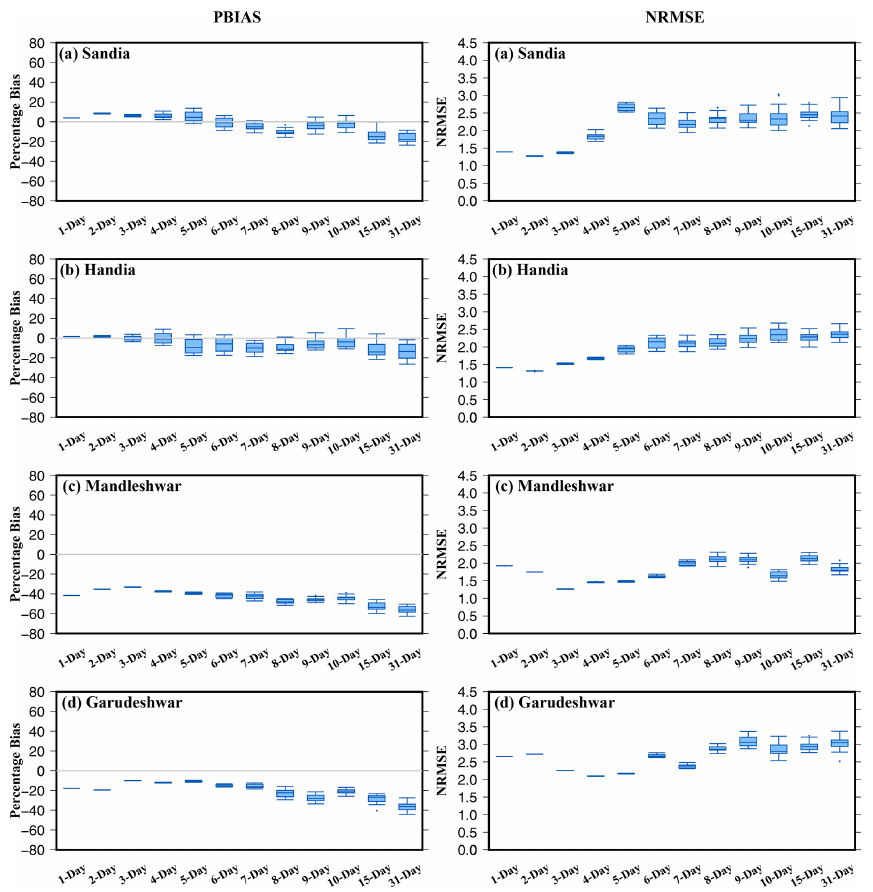
Figure 9. Ensemble streamflow forecast skill based on the ERFS forecast for 2003–2018. The forecast was evaluated using bias (%) and NRMSE. Box and whisker plots show the skill for all 16 ensemble members at leads 1–10, 15 and 31d at 4 gauge stations.